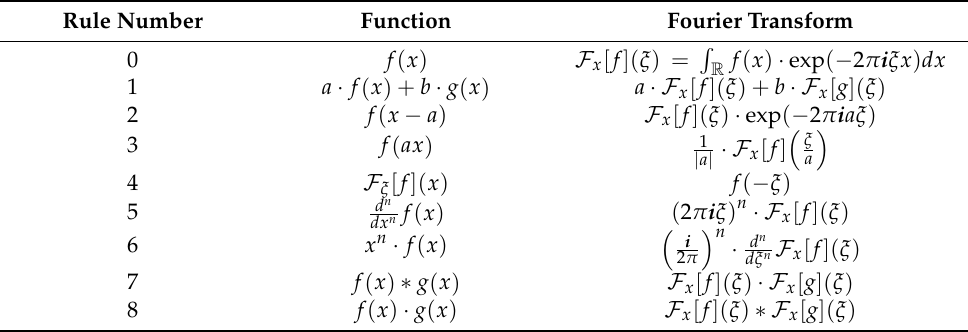
Table A1. Table of some functional Fourier transform pairs [26].